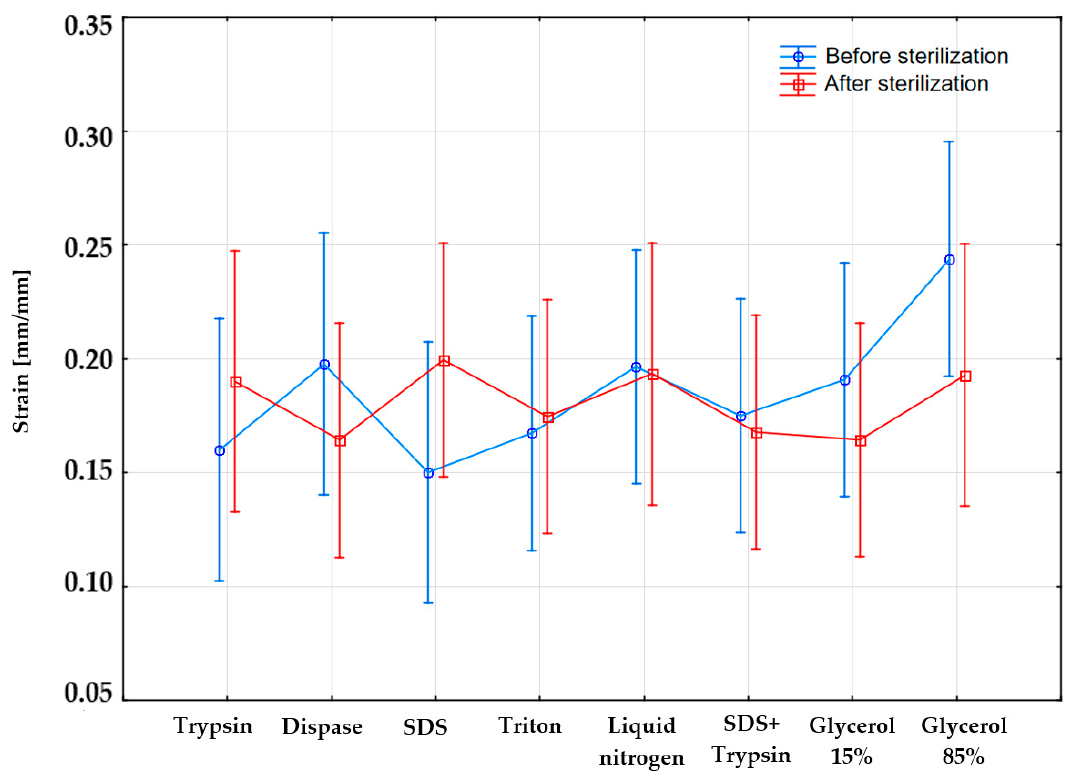
Figure 7. Graphic interpretation of the interaction effect.